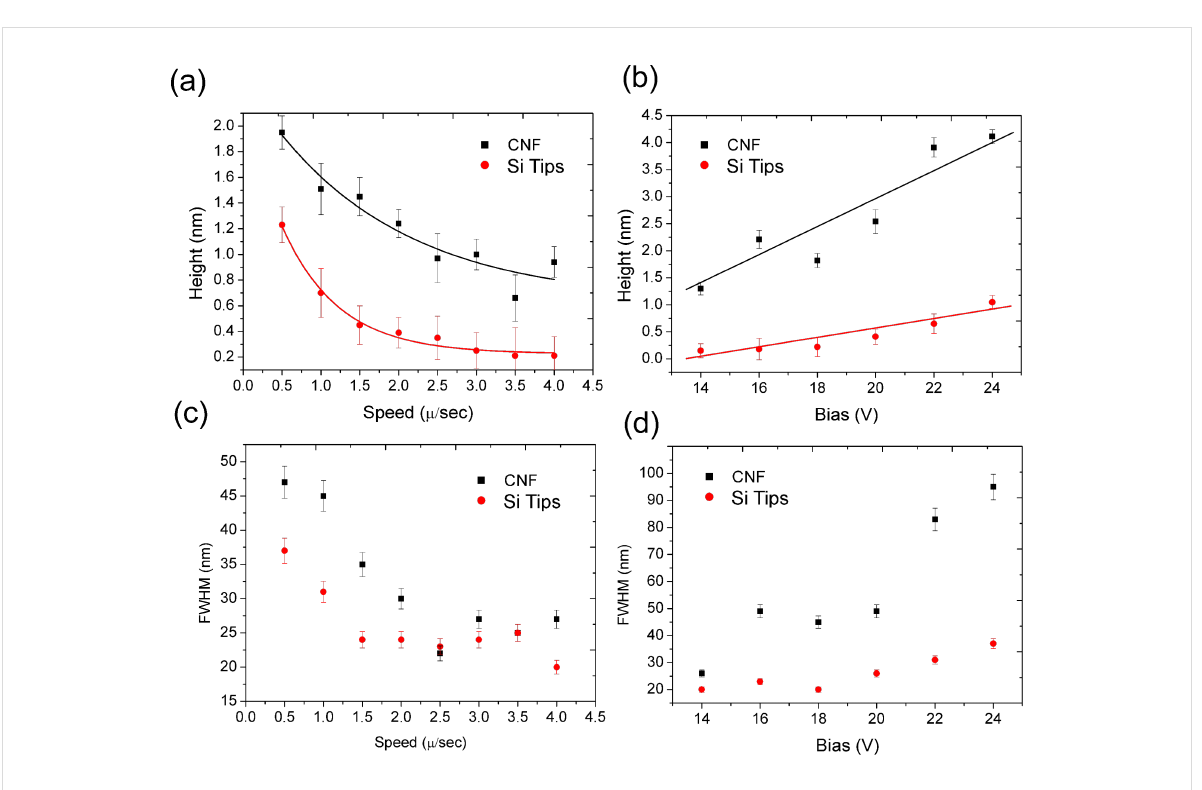
Figure 6: Kinetics of LAO-AFM on Si by using CNF versus Si probes. a) Line height upon writing speed for a bias voltage of 20 V. b) Line height upon bias voltage for a writing speed of 1 μ m/s. Full width at half maximum (FWHM) of the same features upon writing speed (c) and upon bias voltage